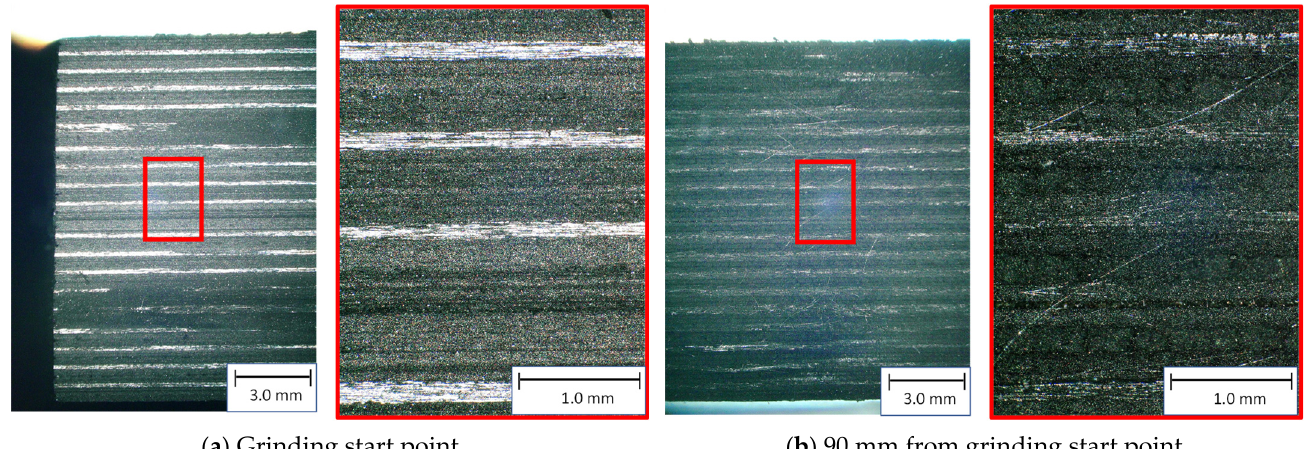
Figure 18. Machined surface of CFRP.